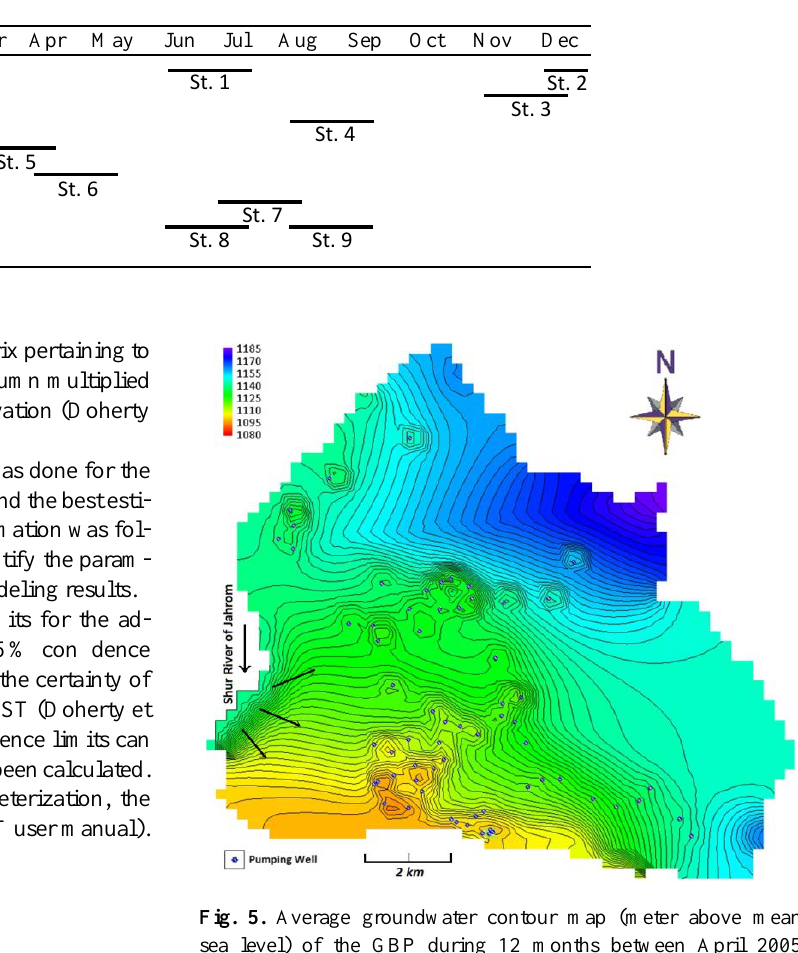
Table 1. Steady-state conditions for all observation wells. Horizontal lines indicate the assumed steady-state (St. 1 to St. 10) periods for two successive months between 1993 and 2007 in model calibration.